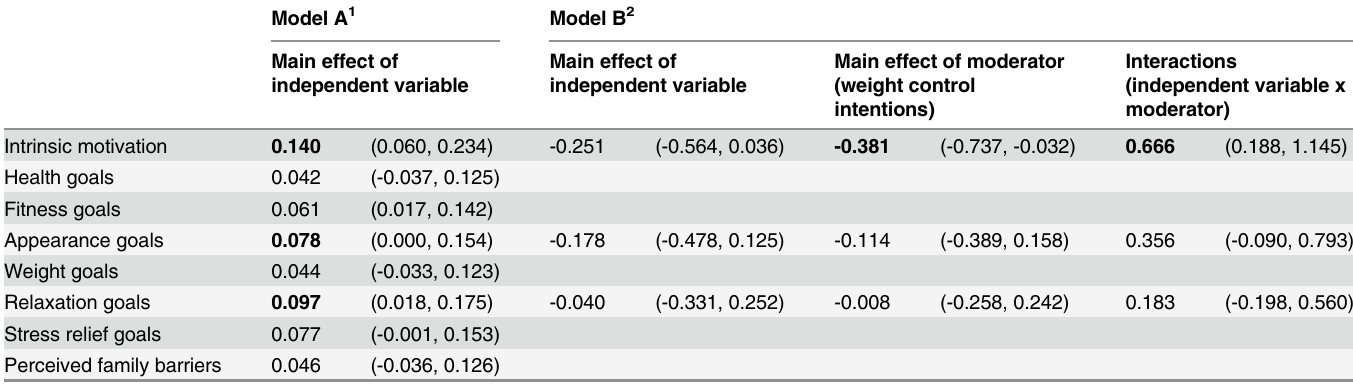
Table 3. Associations between physical activity motivation and barriers and leisure-time physical activity at follow-up, and moderator effects of weight control intentions.